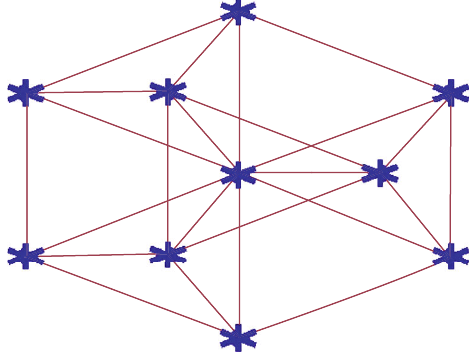
Figure 3: Rod deformation